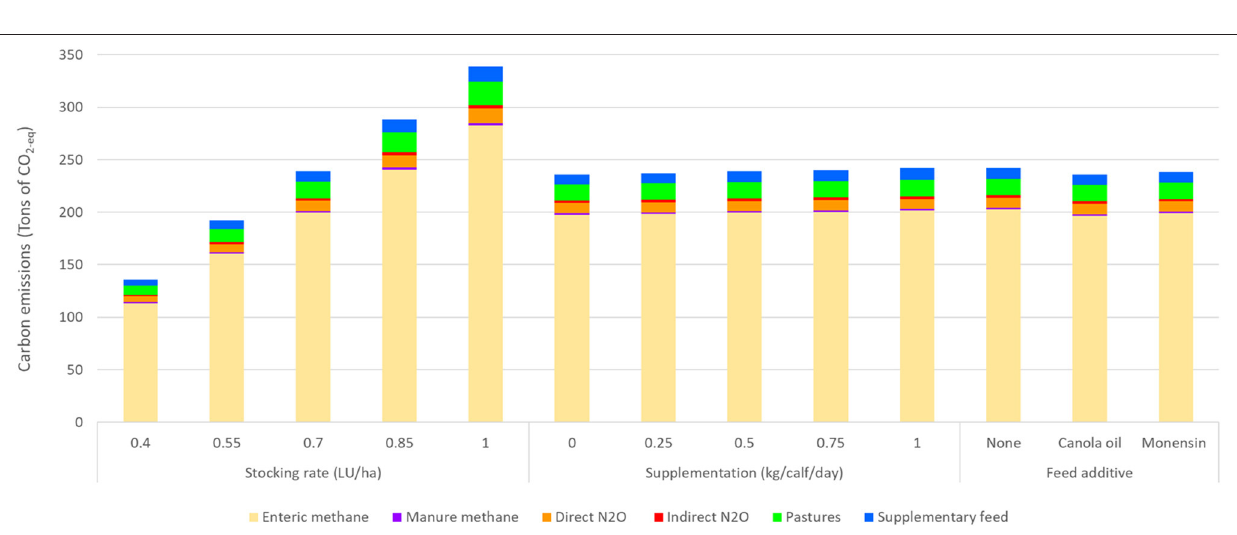
FIGURE 5 | Total greenhouse gas (GHG) emissions according to stocking rate (0.4, 0.55, 0.7, 0.85, and 1 LU/ha), supplementation (creep feeding), and additive (monensin and canola